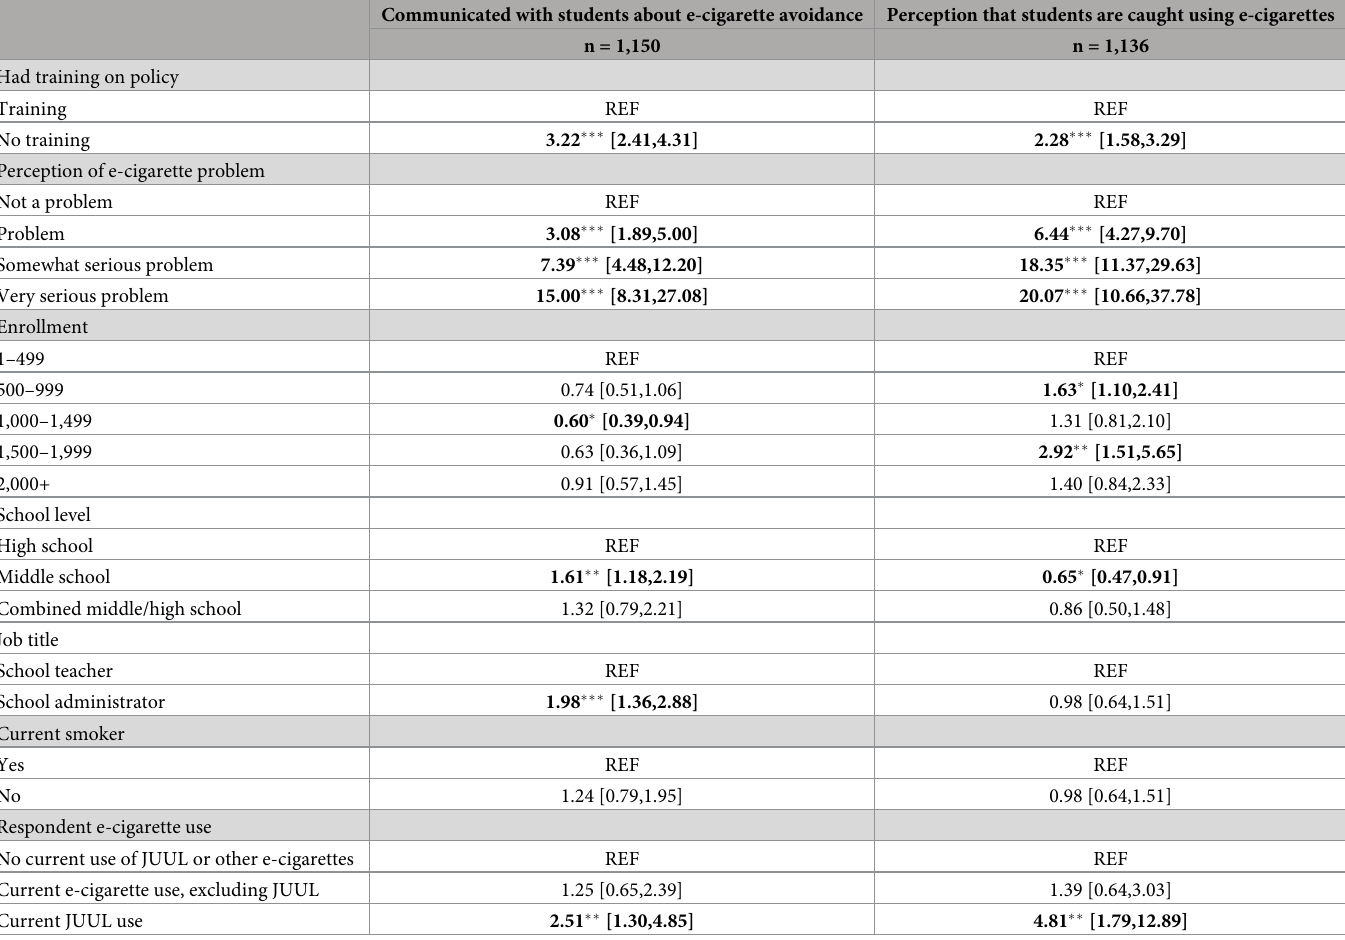
Table 5. Predictors of communicating with students about e-cigarette avoidance among school personnel working in a school with an e-cigarette/JUUL policy. Communicated with students about e-cigarette avoidance Perception that students are caught using e-cigarettes n = 1,150 n =